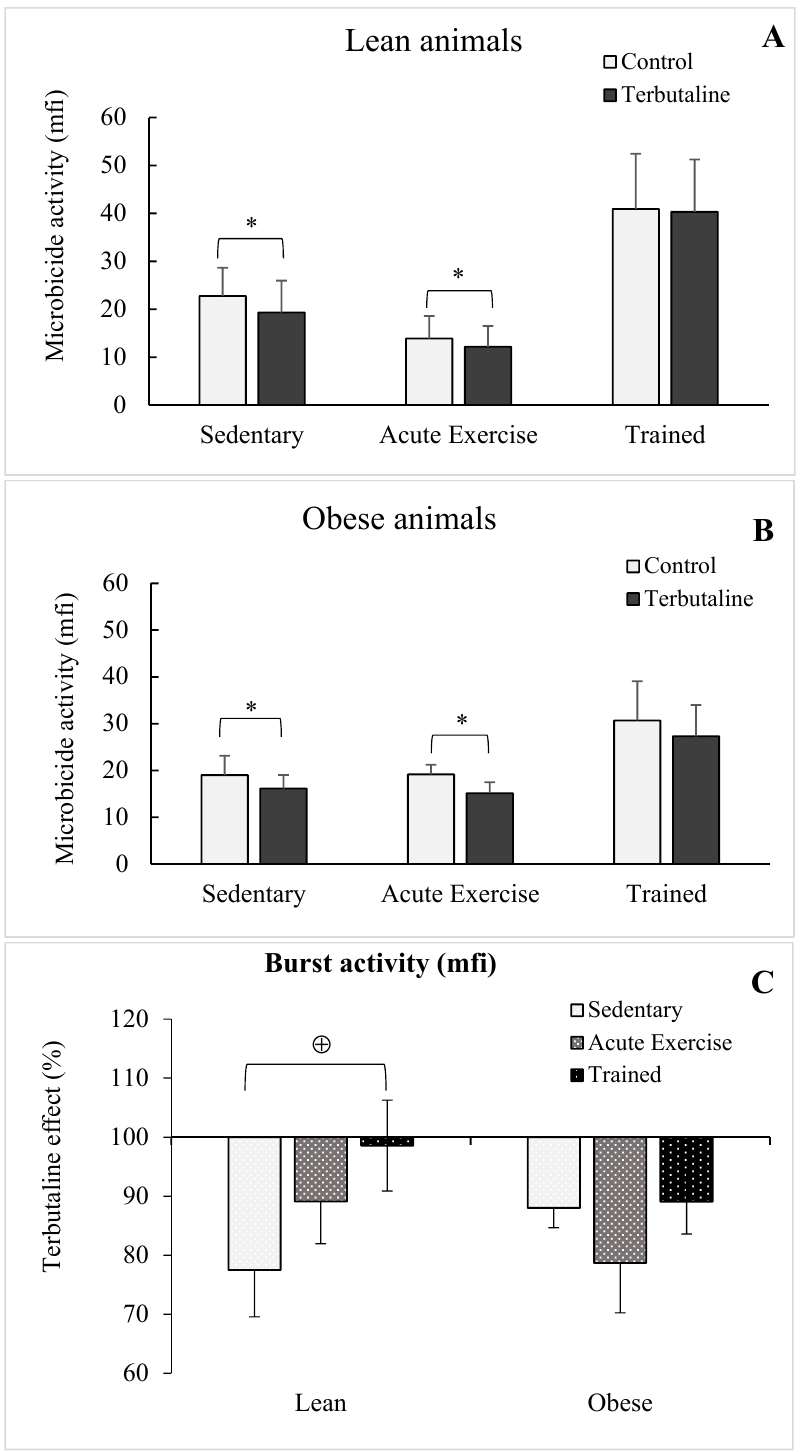
Figure 4. Effect of the β 2-adrenergic agonist terbutaline on the microbicide activity of peritoneal macrophages from lean ( A ) and obese ( B ) mice (sedentary, acute exercise, and trained mice). Effect of terbutaline expressed as percentage change from the baseline ( C ). Columns represent the mean ± SEM of independent assays performed in duplicate. * p < 0.05 with respect to the corresponding control value, in the absence of terbutaline; ⊕ p < 0.05 with respect to the corresponding sedentary group. 3.4. Effect of Obesity and Exercise in the β 2-Adrenergic Receptor Expression in Peritoneal Macrophages